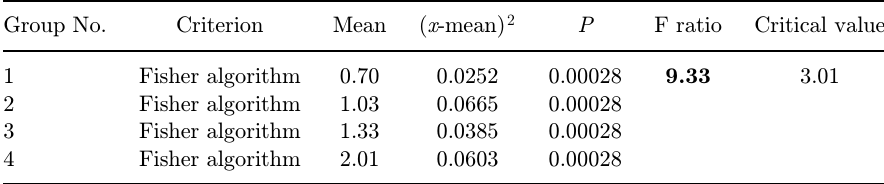
Table 6. ANOVA statistics for four di®erent arm movements on triceps muscle. Group